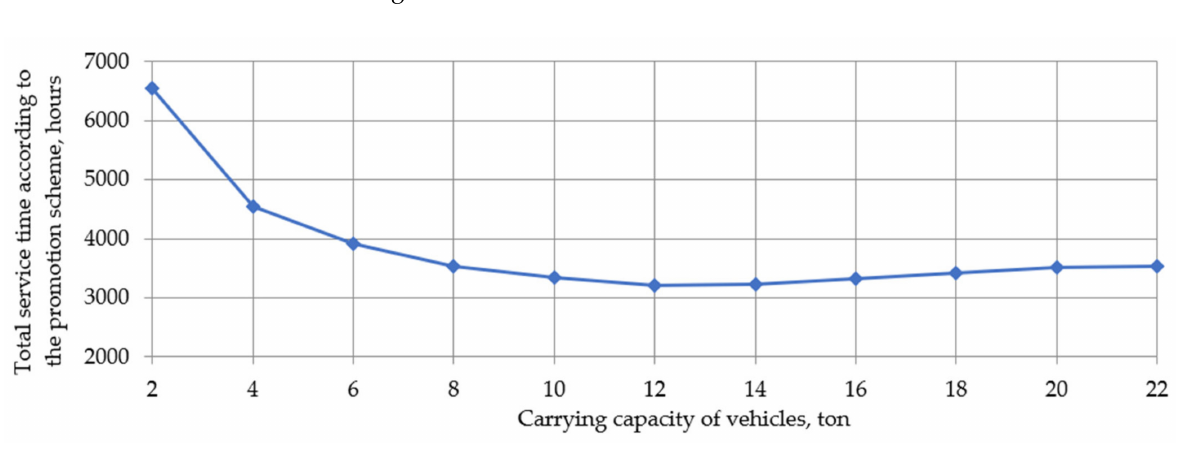
Figure 6. Change of service time according to the distribution scenario during the year depending on the load capacity of vehicles.